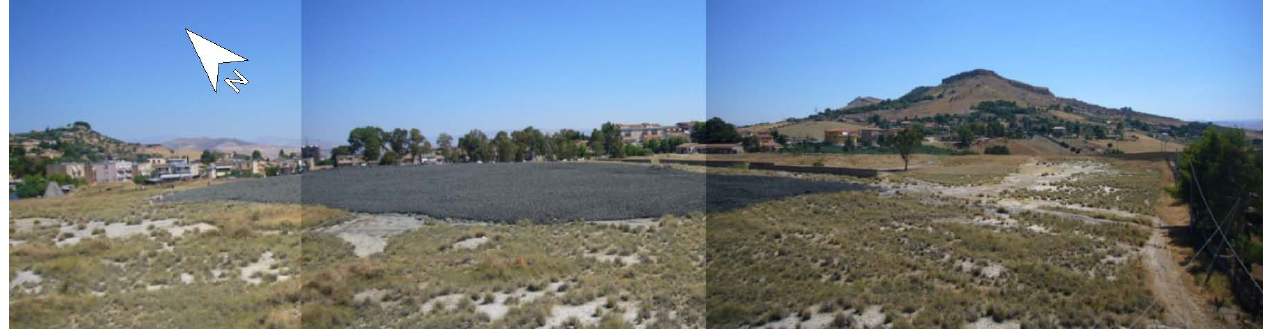
Fig. 3. View of Vulcanello area two days after the 11 August 2008 paroxysmal event. The grey clay deposit is the material erupted by the